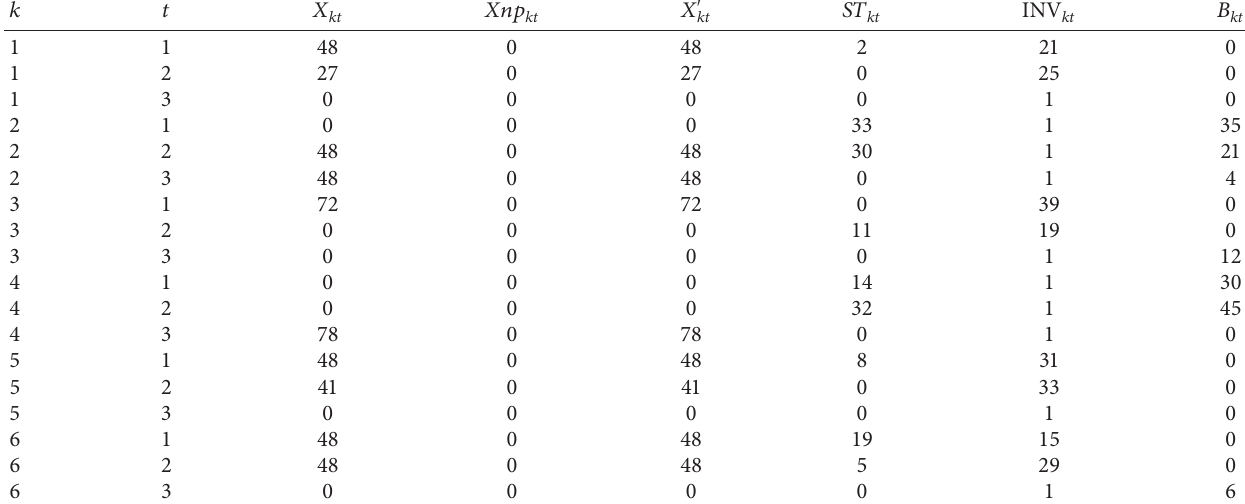
Table 8: Small dataset results of the extended LSSP MILP, with setup common operators: lot-sizing, inventories, coverage stockout, and backorders.